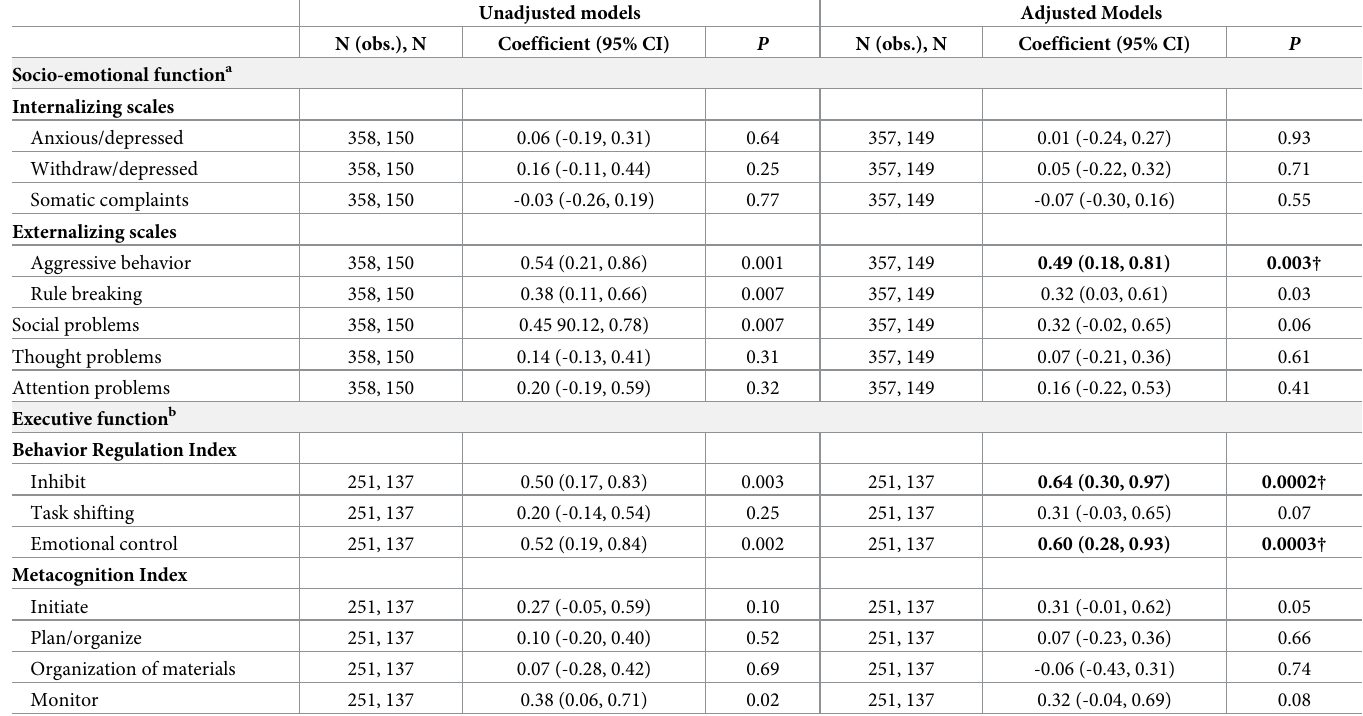
Table 3. Secondary socio-emotional outcomes for children � 6 years with severe malaria by acute kidney injury (AKI)